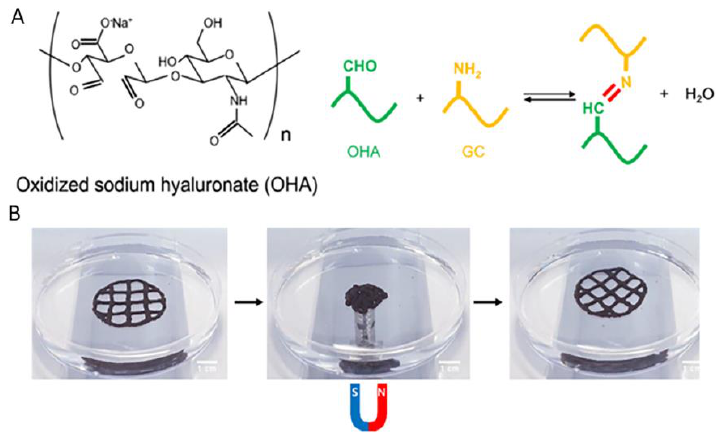
Figure 20. ( A ) Schiff base formation between OHA and GC. ( B ) Change in the 3D-printed structure by application of a magnetic field. The original shape was recovered after removal of the magnetic field. Reprinted from [56], Copyright 2020, Elsevier.